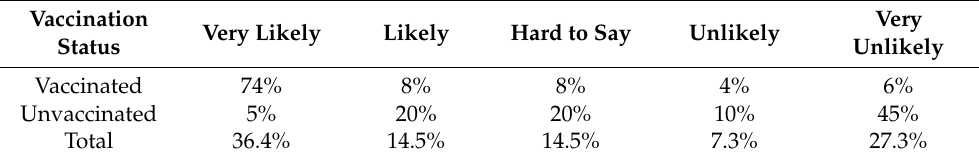
Table 2. Percentage of responses regarding the intention to vaccinate for travel “How likely is it you will get a COVID-19 vaccine that is freely available and recommended by authorities, if it allows you to travel to the desired